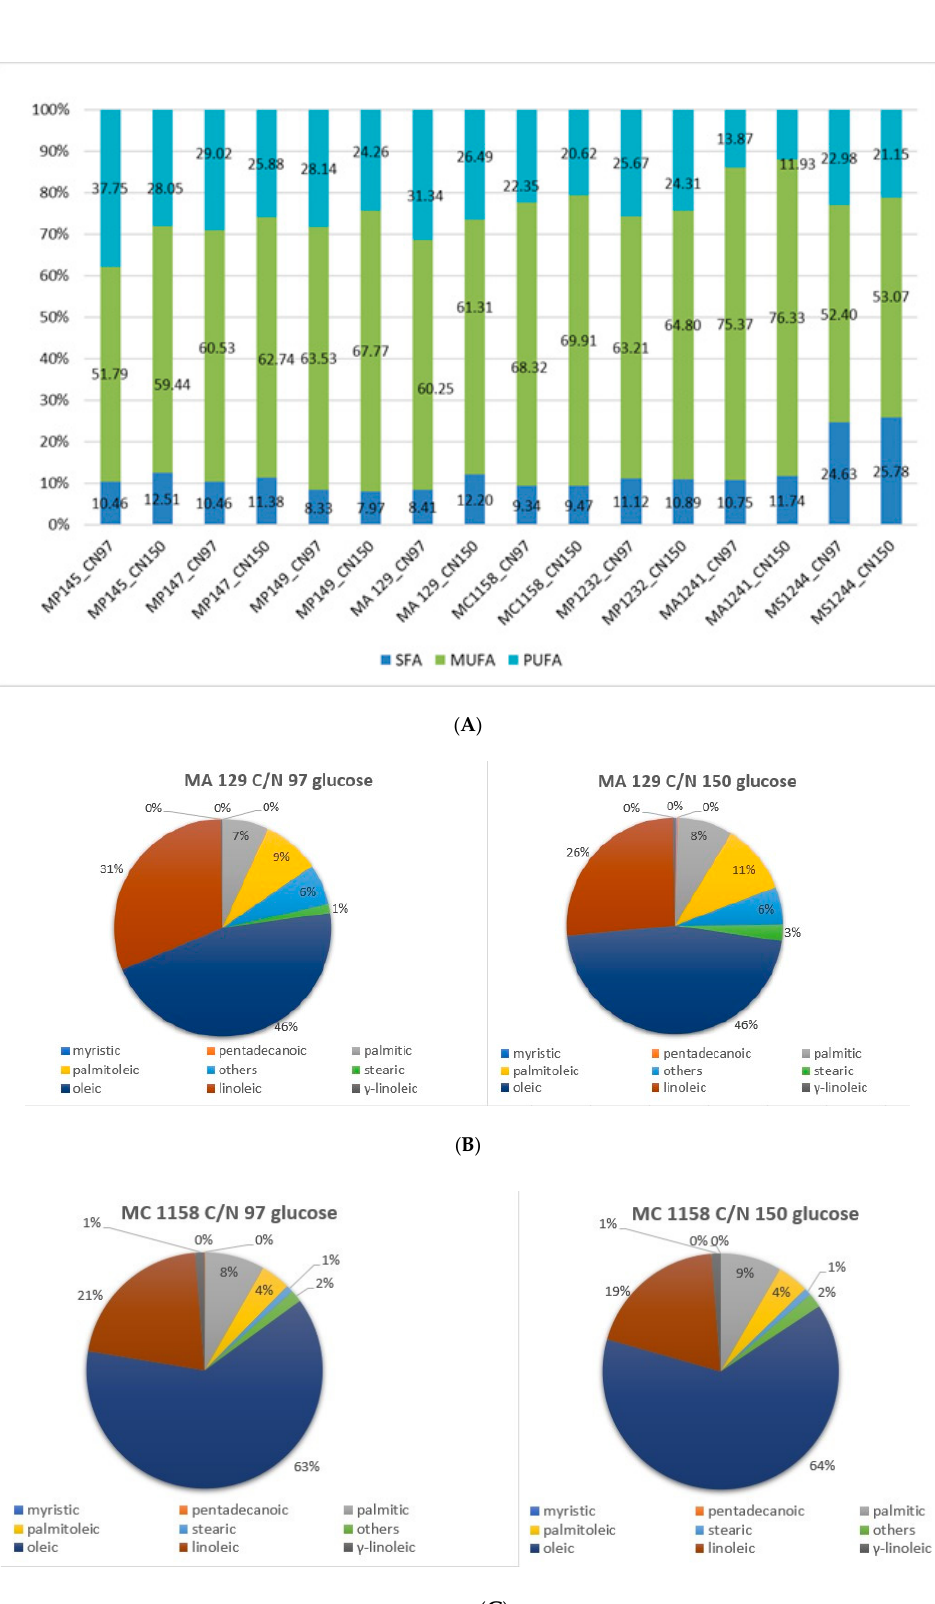
Figure 9. ( A ) Percentage of saturated (SFA), monounsaturated (MUFA) and polyunsaturated (PUFA) FA in selected yeast strains grown on glucose medium with C/N ratio of 97 and 150. ( B ) Percentage of selected fatty acids in Metschnikowia andauensis 129 grown on glucose medium with C/N ratio of 97 and 150. ( C ) Percentage of selected fatty acids in Metschnikowia chrysoperlae 1158 grown on glucose medium with C/N ratio of 97 and 150. In further experiments, Metschnikowia sinensis 1244 was cultivated in media contain- ing both C/N ratios. We monitored production of palmitic and stearic acids, too. Produc- tion of stearic acid (18:0) was at 13.48% the highest amount from strains covered by our study. The other strains under our investigations produced only about 2% of stearic acid. Fatty acid profiles in lipids produced by Metschnikowia strains which were analyzed in our study can be broadly compared with the study of Santamauro et al. (2014). In our experiments, the production of linoleic acid was higher, and this can be attributed to the C/N ratio; this was different from the study by Santamauro et al. [37]. Raman spectroscopy serves as an efficient and easy alternative method also for lipid detection, as demonstrated above. This technique provides a quick detection of the satu- rated and unsaturated bonds of lipids contained in yeast cells. The intensity of specific spectral peaks can be used for the estimation of unsaturation degree in the form of the iodine number [31]. The spectral peaks ν U at 1656 cm − 1 (proportional to the amount of unsaturated C = C bonds) and ν S at 1445 cm − 1 (proportional to the amount of saturated C- C bonds) were used [31]. The iodine number of each sample was determined by using the equation derived in Figure 10.